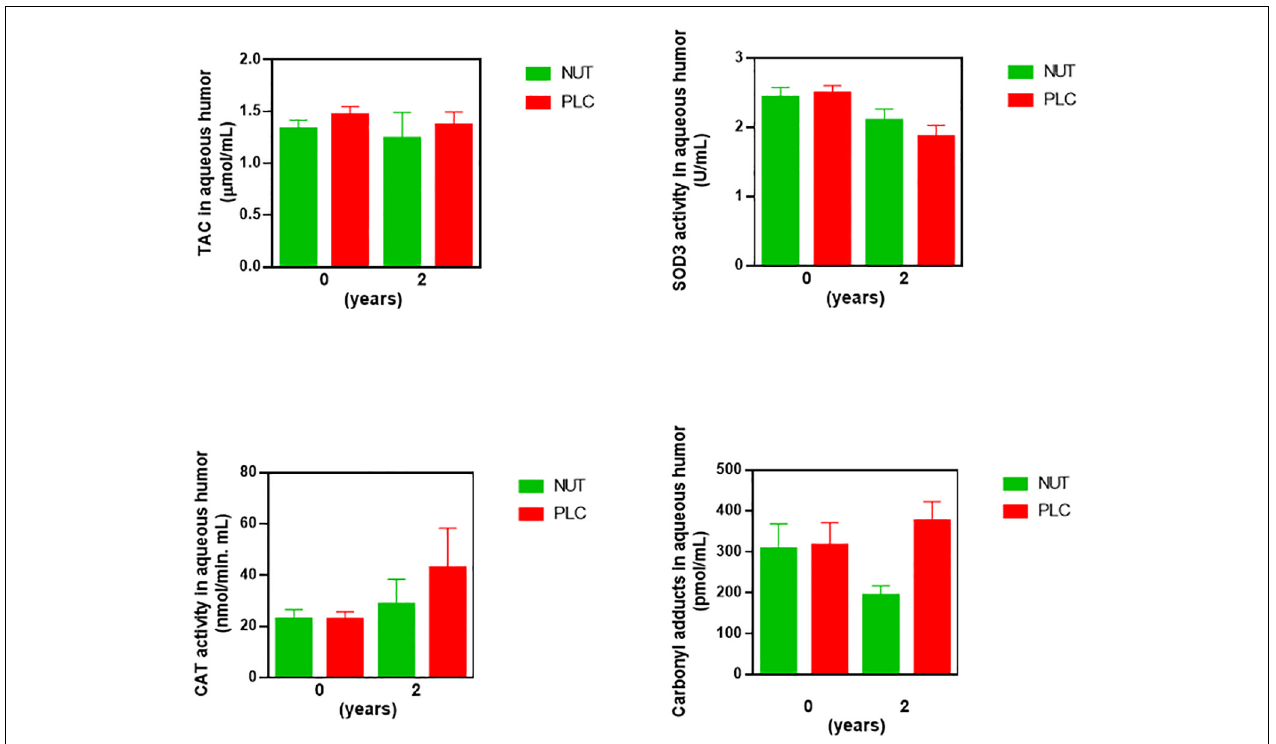
FIGURE 6 | Concentrations of antioxidant, oxidant, and inflammatory markers in aqueous humor of RP patients after 2 years of supplementation. Ocular redox status was determined by measuring total antioxidant capacity (TAC), extracellular superoxide dismutase (SOD3), and catalase (CAT) activities, and protein carbonyl adduct (CAR) content with commercial kits. All data were plotted in bar graph with standard error bars. NUT, patients with RP who daily received a mixture of nutraceuticals; PLC, patients with RP who daily received